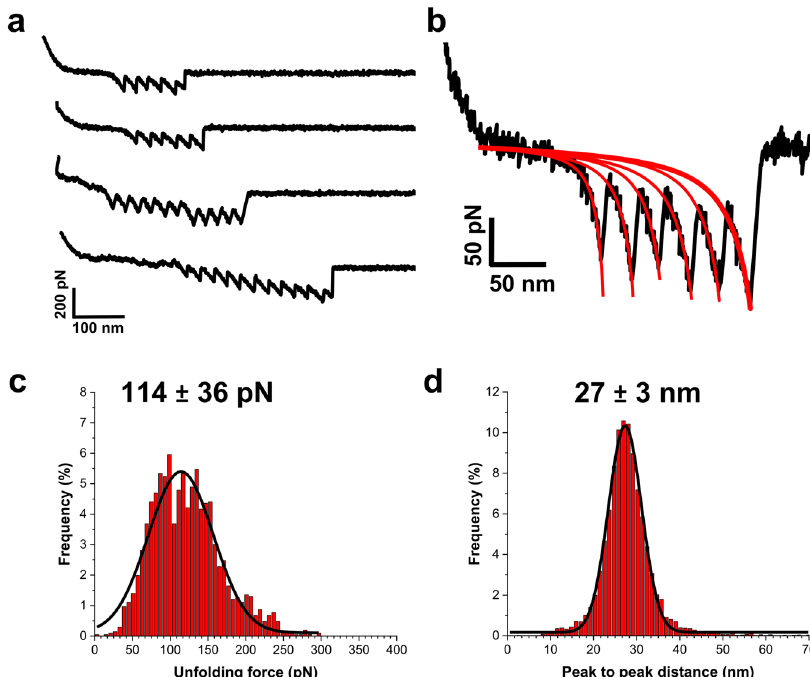
Fig. 2 Force-induced unfolding of the fH repeats. a Representative retraction pro fi les obtained by pulling fH tips away from the surface of SdrE ( + ) cells, featuring the sequential unfolding of individual fH repeats. Two types of multi-peak patterns were observed, re fl ecting either the unfolding of the six repeats of fH monomers (upper curves) or the twelve repeats of fH dimers (lower curves). b Unfolding forces (black line) were well- fi tted by the worm- like-chain (WLC) model (red lines), calculated using the equation: F ð x Þ ¼ k B T l the stiffness and l p the persistence length. c Unfolding force and d peak to peak distance histograms resulting from the analysis of the unfolding patterns from three independent SdrE ( + ) cells ( n > 2000 and 10,000 unfolding peaks, respectively). Both histograms were well- fi tted by a gaussian function (black lines), yielding an average unfolding force of 114 ± 36 pN and an average peak-to-peak distance of 27 ± 3